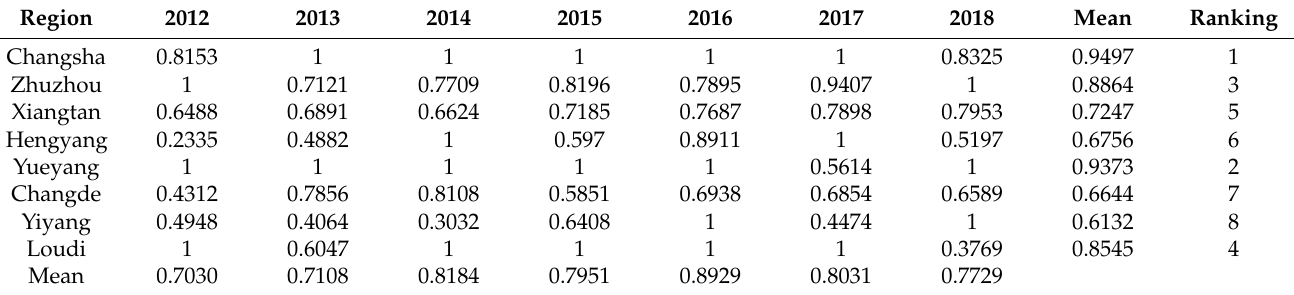
Table 3. Green innovation efficiency of urban